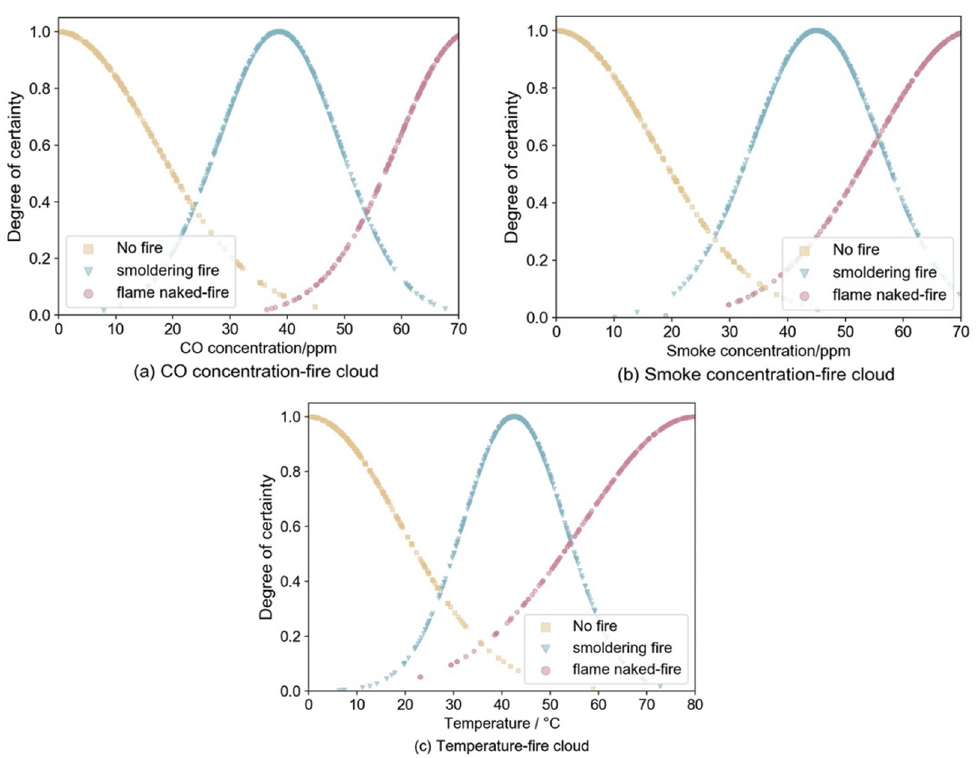
Figure 7. Fire characteristic parameter cloud chart. ( a ) CO concentration-fire cloud chart. ( b ) Smoke concentration-fire cloud chart. ( c ) Temperature-fire cloud chart.